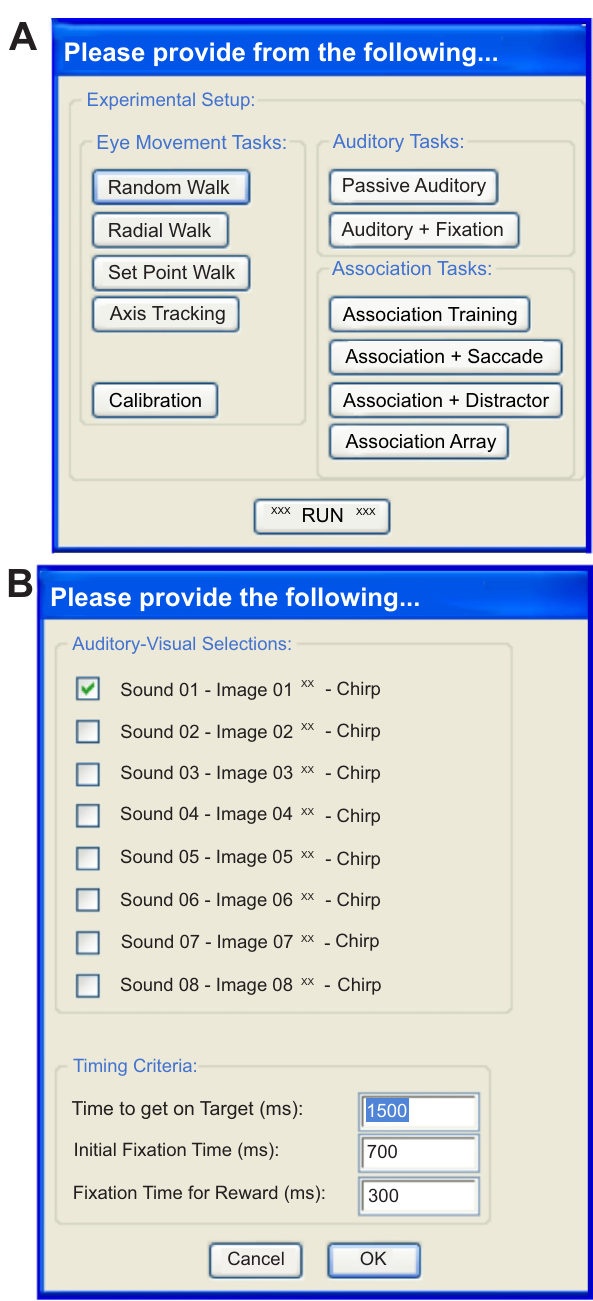
Figure 3. Menu-driven user interface . A . The list of proposed paradigms users may select from to start a session; currently available are Calibration and the Association Tasks, and include “walk” tasks that were not implemented in the present version. “Walks” are saccade tasks designed to use a single target that appears on a black screen in various locations, moving in patterns ascribed by the selection buttons and subsequent dialogs boxes that may be added by the user. They can be used to train the animal and record metrics of their eye movements. B . User-interface that allows for selection of the auditory-visual pairing used during the association training paradigm and the timing criteria necessary for successful completion of the